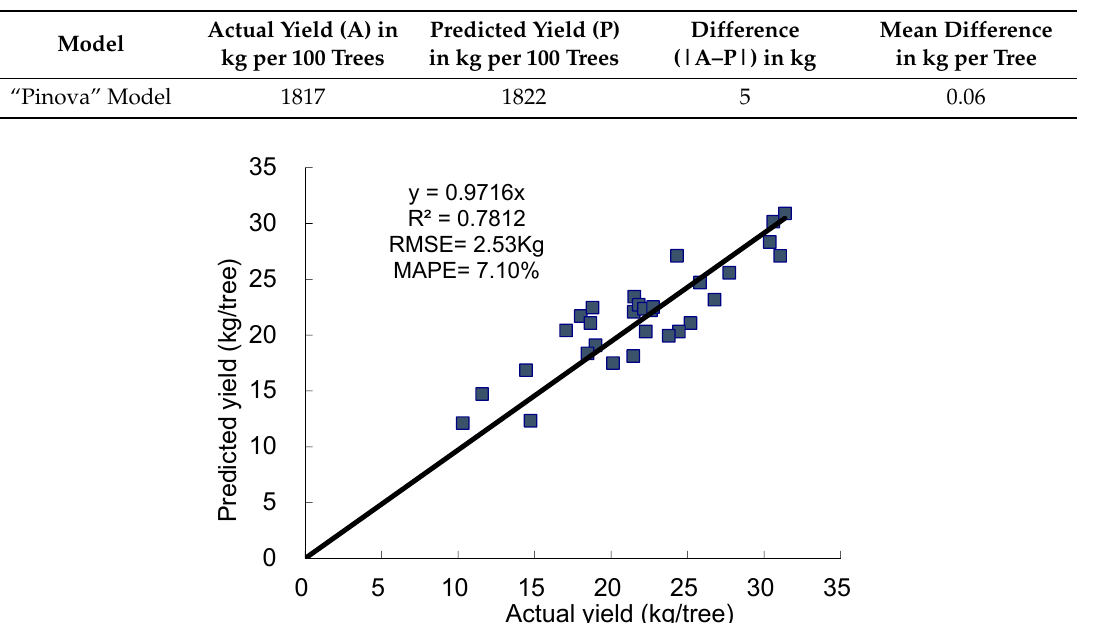
Table 8. Comparison between actual yield and predicted yield for 2012; n = 90 trees.